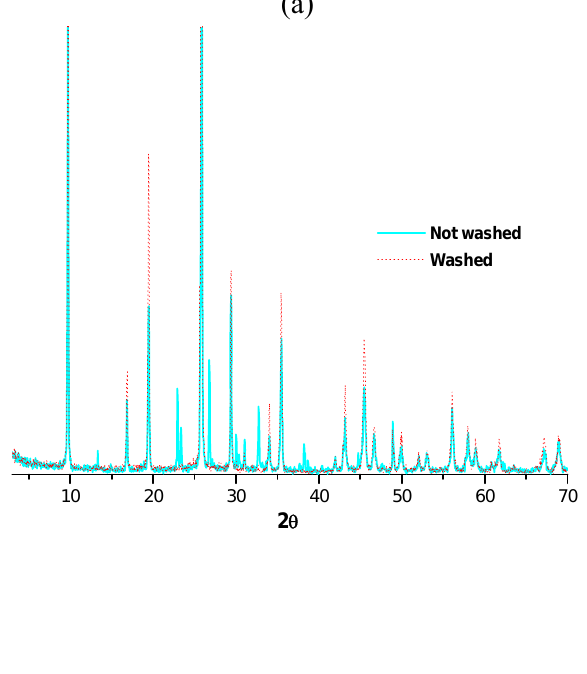
Figure 3. Generator matrix washing effect on (a) X-ray diffraction patters; (b) thermograms and (c)